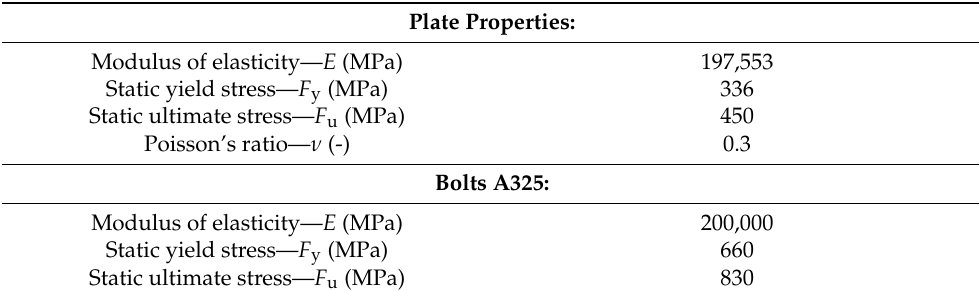
Table 1. Material properties, mean value.